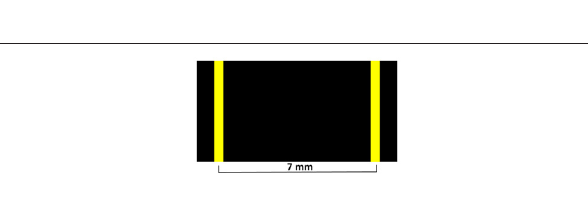
SCHEME 2 | Illustration of samples prepared for sensor